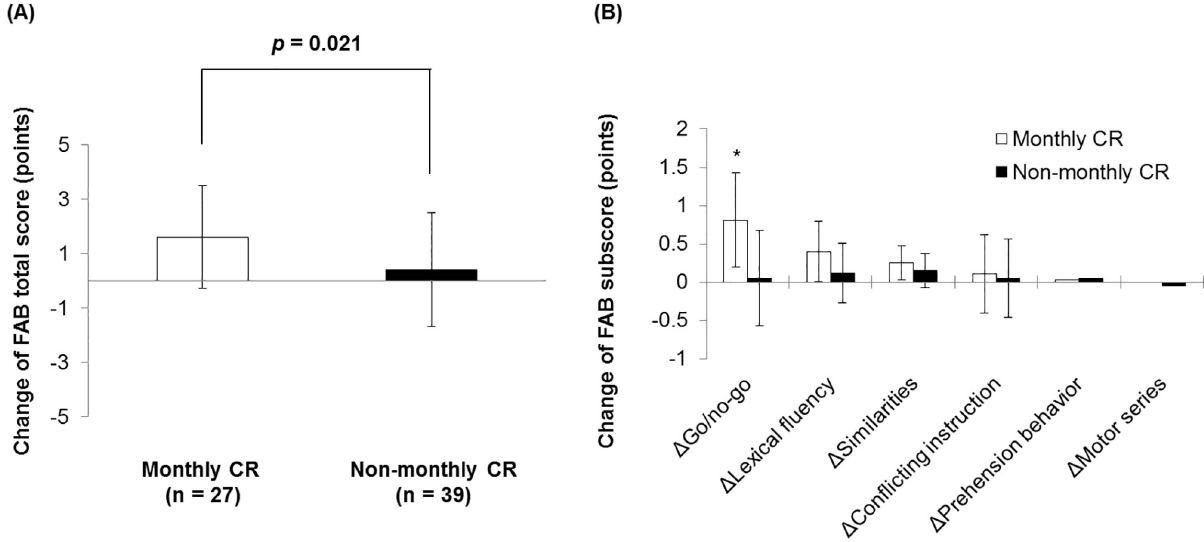
Fig 2. Change in the FAB score during 6 months. (A) Change in the FAB total score during 6 months between the monthly CR group and the non- monthly CR group. (B) Changes in FAB items during 6 months between the monthly CR group and the non-monthly CR group. CR, cardiac rehabilitation; FAB, Frontal Assessment Battery.